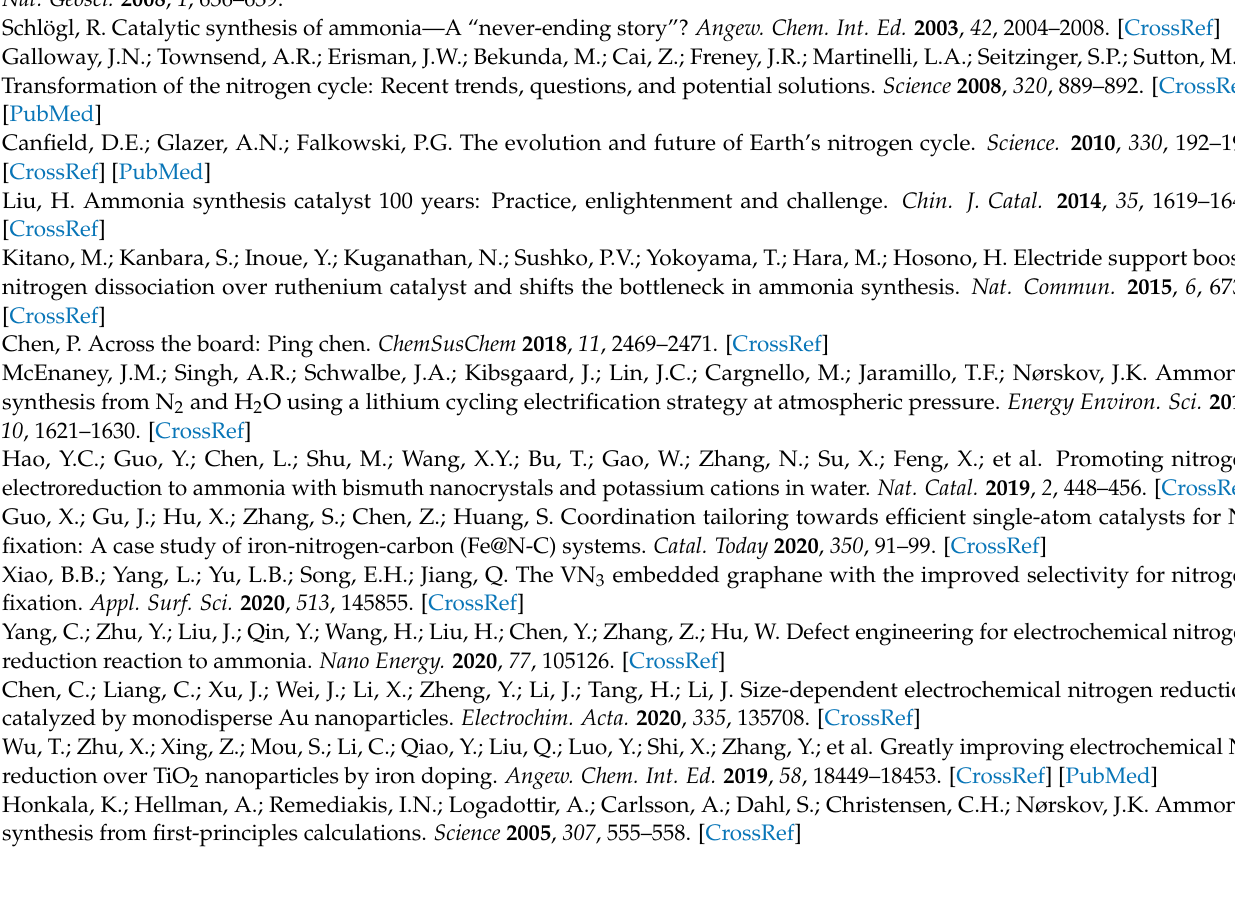
g-C3N4. Figure S2: Spin electrons distribution of TM@ g-C3N4. Figure S3: DOS of TM@ g-C3N4. Figure S4 Optimized adsorption structures of intermediate via the alternating and distal mecha- nisms. Figure S5. Diagram of the moiety 1(g-C3N4), moiety 2 (V-3N) and moiety 3 (the adsorbed intermediate